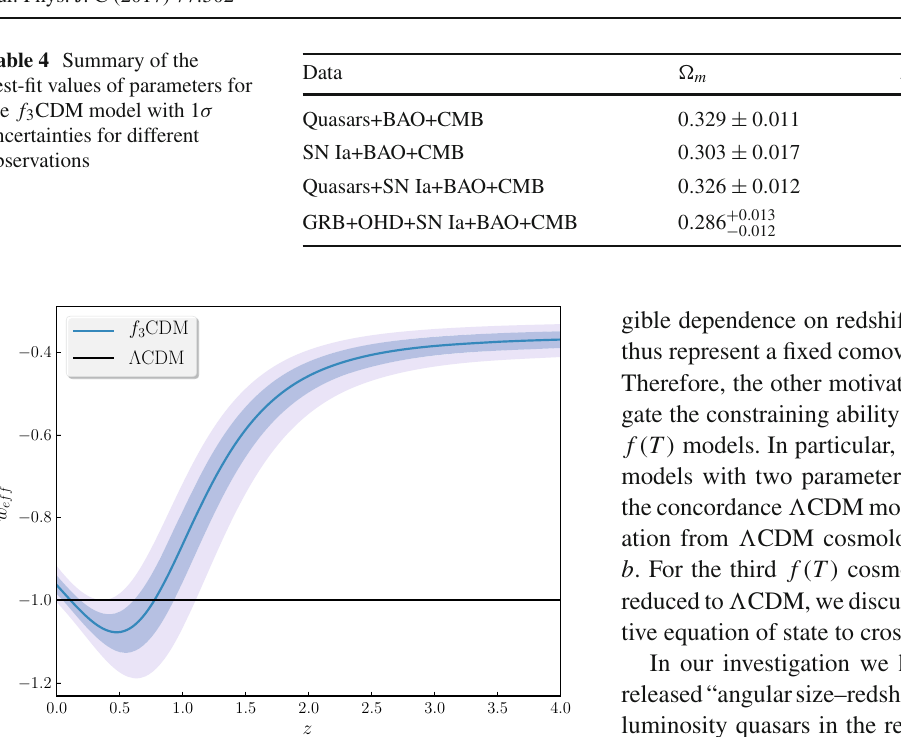
Fig. 9 Evolution of the EoS for (cid:3) CDM and the effective EoS for the f 3 CDM model from the joint analysis quasars+BAO+CMB